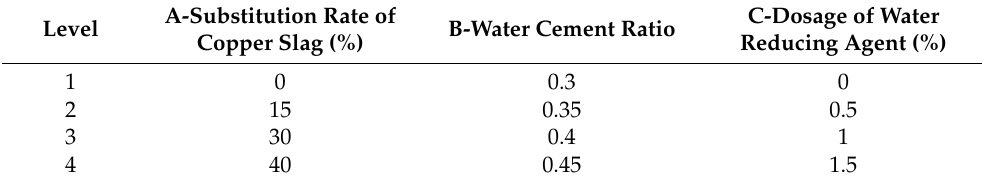
Table 6. Orthogonal factor level